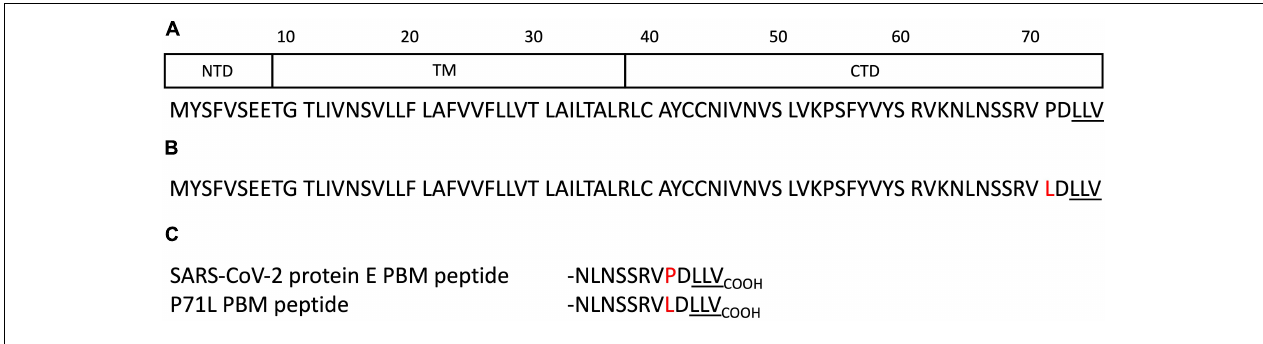
FIGURE 1 | Schematic domain representation and sequences of the protein E constructs. (A) Domain delimitations and sequence of the full-length protein E of SARS-CoV-2. NTD, TM, and CTD correspond to the N-terminal domain, the transmembrane domain, and the C-terminal domain respectively. (B) Sequence of the full-length protein E of SARS-CoV-2 beta variant (B.1.351). (C) Sequences of the SARS-CoV-2 WT and the beta variant E C-terminal encompassing the PSD-95/Dlg/ZO-1-binding motif (PBM). The PBMs are underlined. The mutation is highlighted in red. TABLE 1 | Selected human PSD-95/Dlg/ZO-1 (PDZ) domains targeted by the SARS-CoV-2 E protein PSD-95/Dlg/ZO-1-binding motif (PBM). PDZ